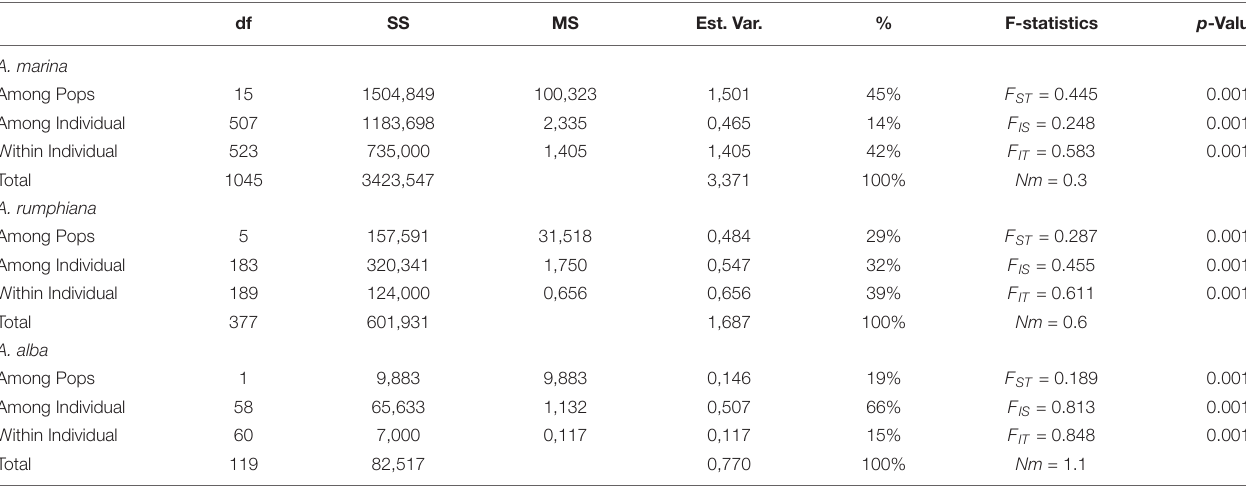
TABLE 3 | Summary of AMOVA and F -statistics of Avicennia marina , Avicennia rumphiana and Avicennia alba mangrove fragments along coasts of Oriental Mindoro, Romblon, and Western Leyte (Philippines). df